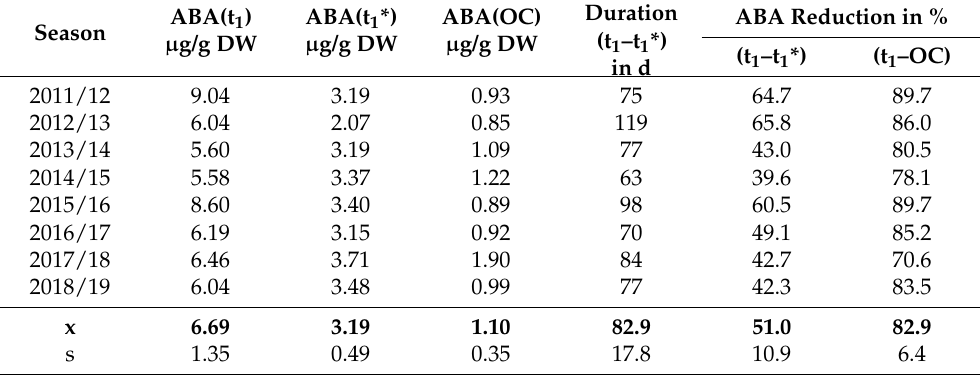
Table 3. ABA content at phenological stages, duration of ecodormancy (t 1 –t 1 *) and ABA reduction (%) from t 1 until t 1 * and OC, 2011/12–2018/19. x: mean, s: standard deviation, t 1 : endodormancy release, t 1 *: beginning of ontogenetic development, OC: ‘open cluster’.